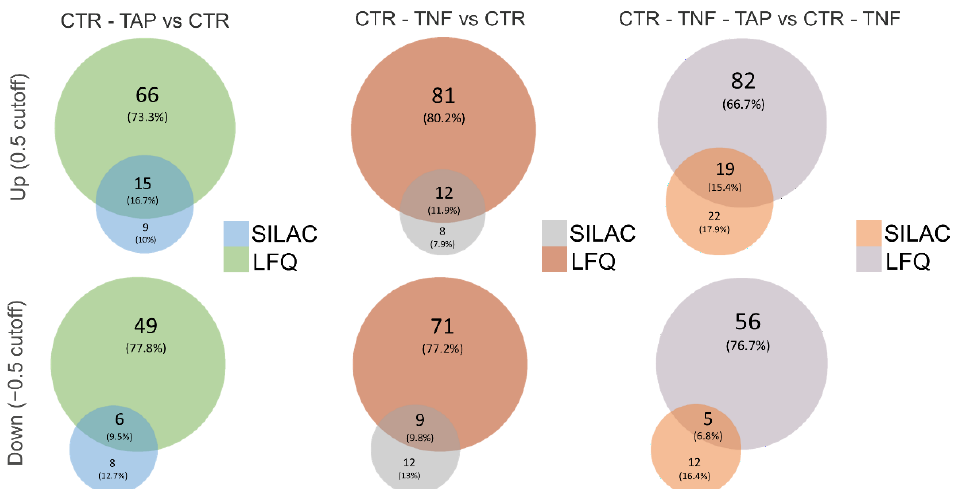
Figure 8. Venn diagrams showing technical differences in terms of the number of significantly (log ratio cutoff ± 0.5) up- (first line diagrams) and down-regulated (second line diagrams) proteins identified by the two approaches in the three comparison analyses (CTR-TAP vs. CTR; CTR-TNF vs. CTR; CTR-TNF-TAP vs. CTR-TNF). Additionally, the percentage distribution of identifications in the two approaches and the percentage of common assignments are shown for each diagram.